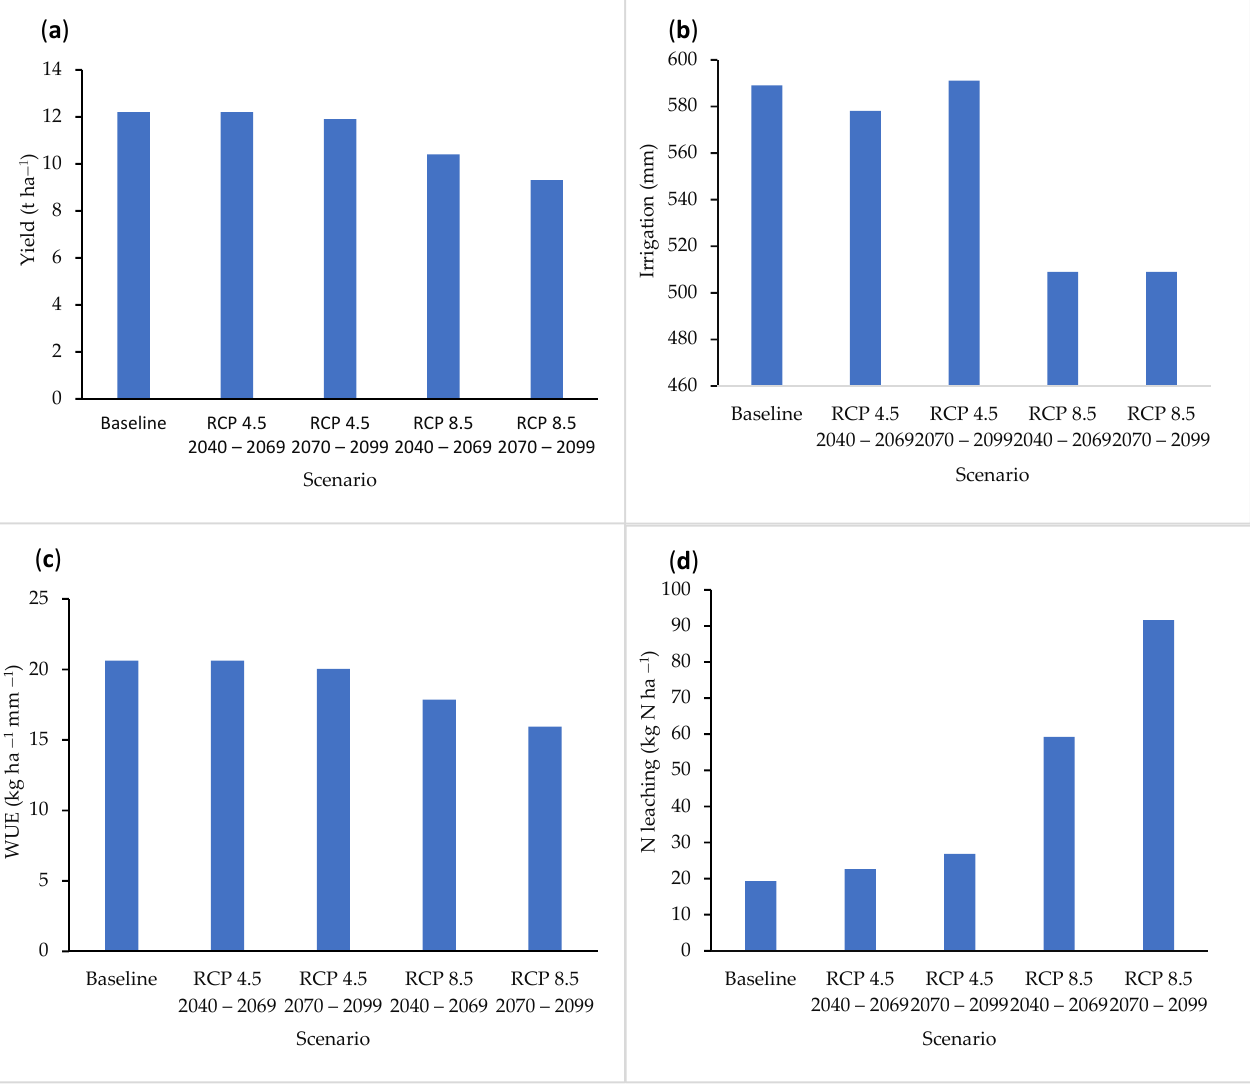
Figure 6. EPIC model outputs from the simulations using GFDL climate data. Values are plotted and shown for the two 30-year periods compared to the baseline simulation; ( a ) yield, ( b ) seasonal irrigation, ( c ) water use efficiency (WUE), ( d ) N leaching.